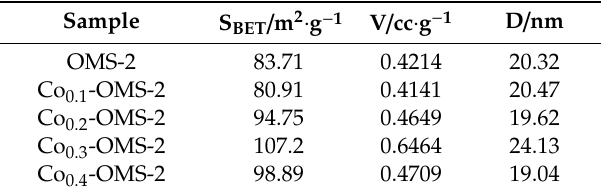
Figure 2. Nitrogen absorption / desorption isothermal curves of OMS-2 samples. ( a ) Co 0.1 -OMS-2 ( b ) Co 0.2 -OMS-2; ( c ) Co 0.3 -OMS-2; ( d ) Co 0.4 -OMS-2). Table 1. Specific surface area / pore volume / average pore size of